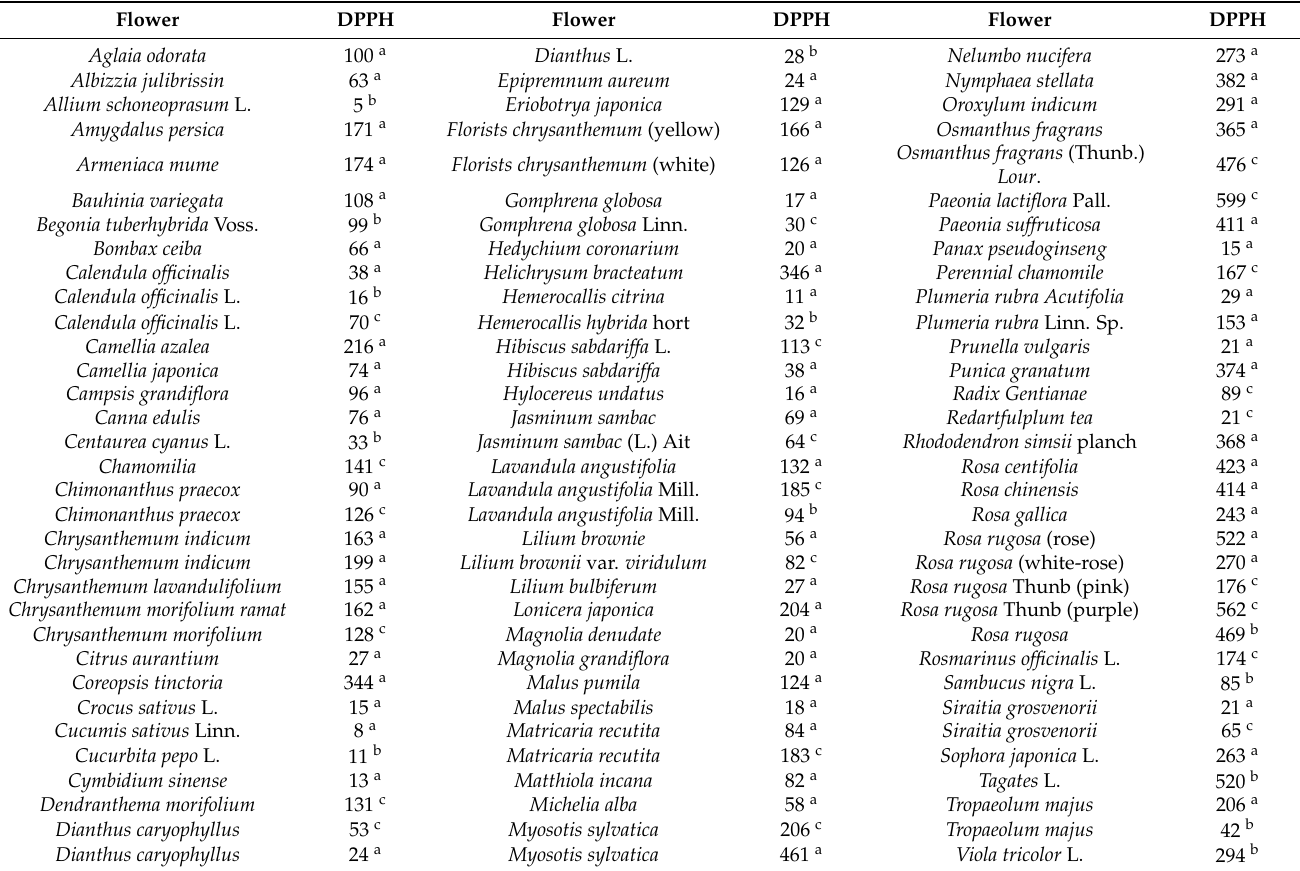
Table 14. Antioxidant activity (DPPH, µ mol TE/g in DW) of several edible